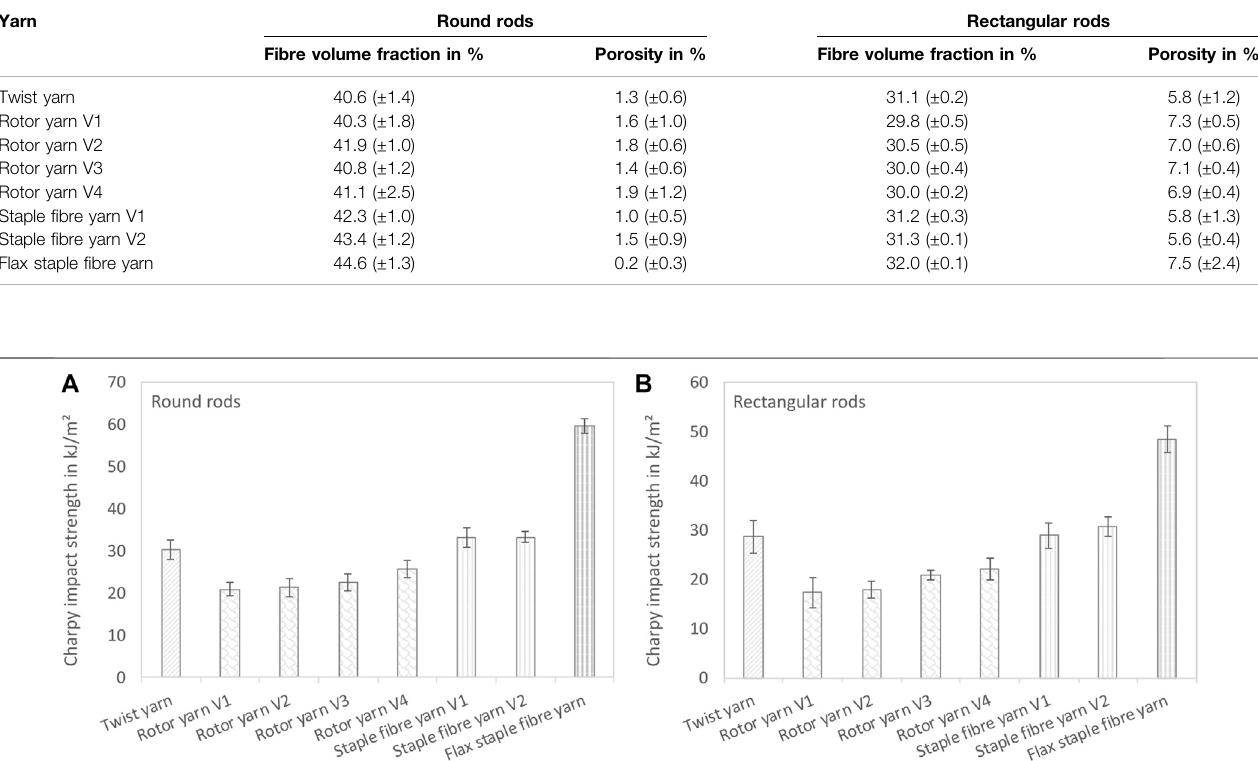
FIGURE 4 | Unnotched Charpy impact strength (mean value ± standard deviation) of pultruded round rods with a fi bre volume fraction of 40% (A) and rectangular rods with a fi bre volume fraction of 30% (B) .